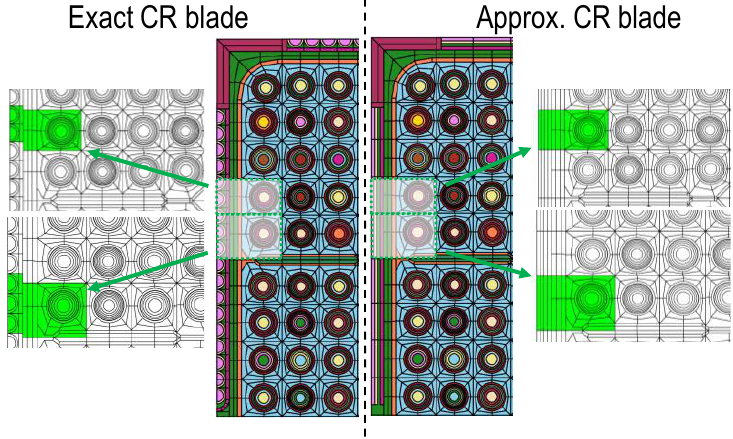
Figure 3. Exact CR blade model (left) and equivalent approximate CR blade model (right) for rectangular shapes of boundary pin